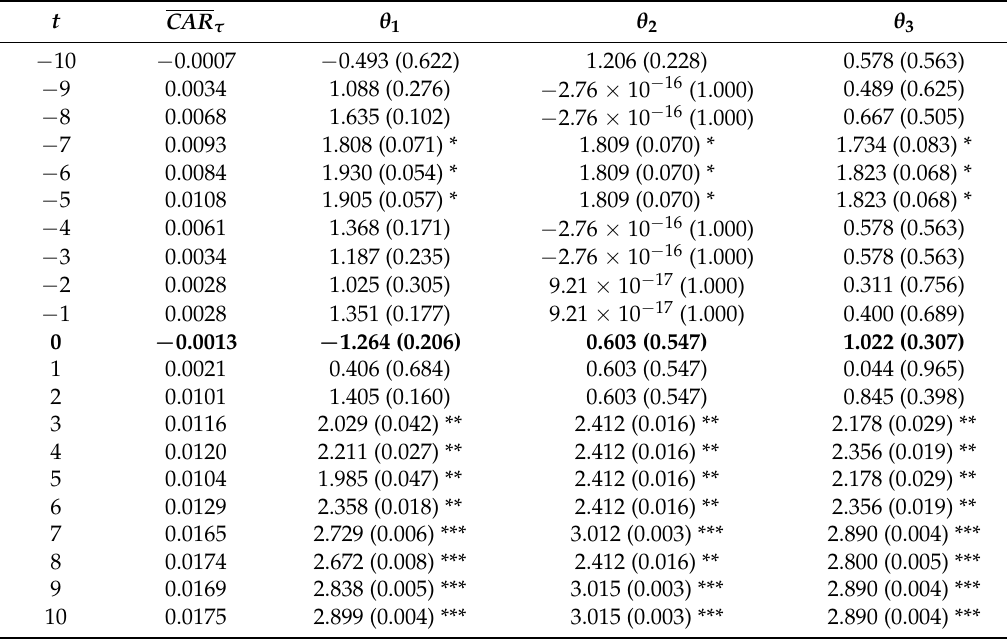
Table 2. Stock market reactions to Brexit, SEE regional factor.